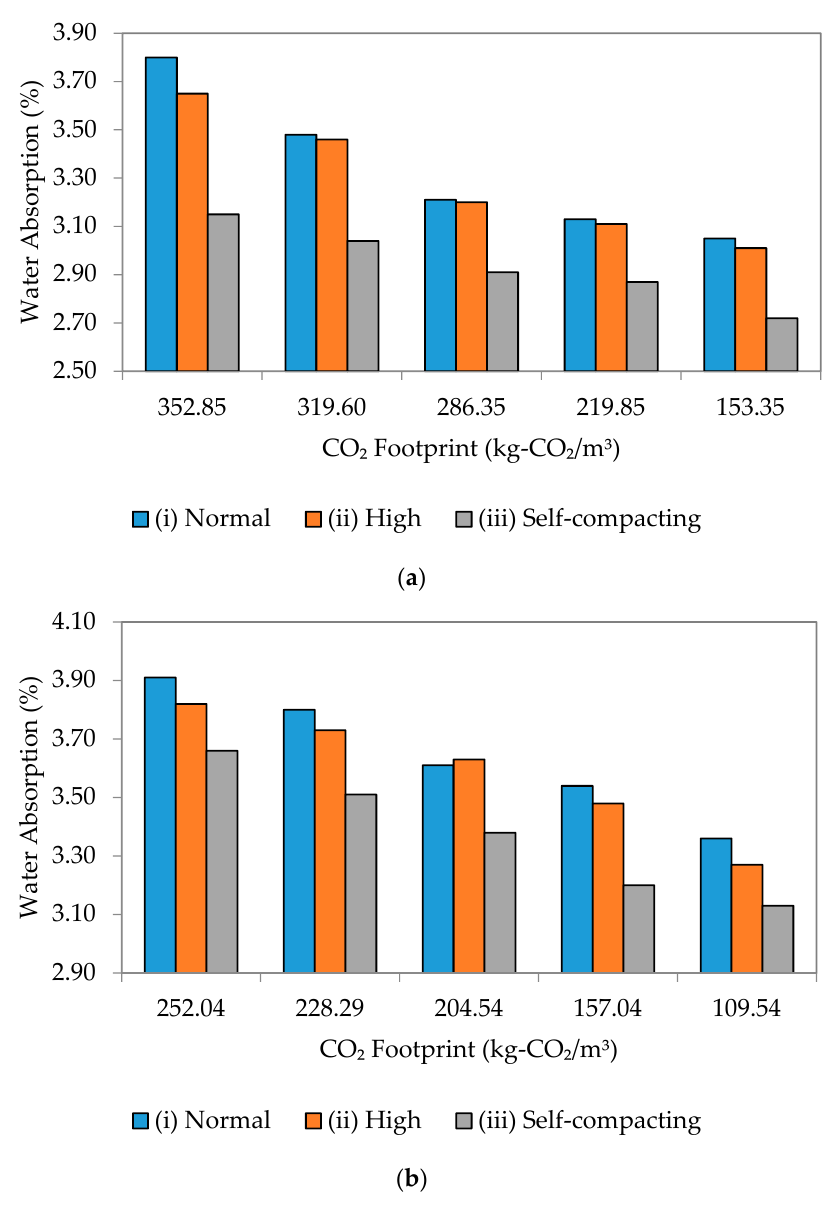
Figure 19. Water absorption to CO 2 footprint of different flowability. ( a ) w/b 0.45; ( b ) w/b 0.50.